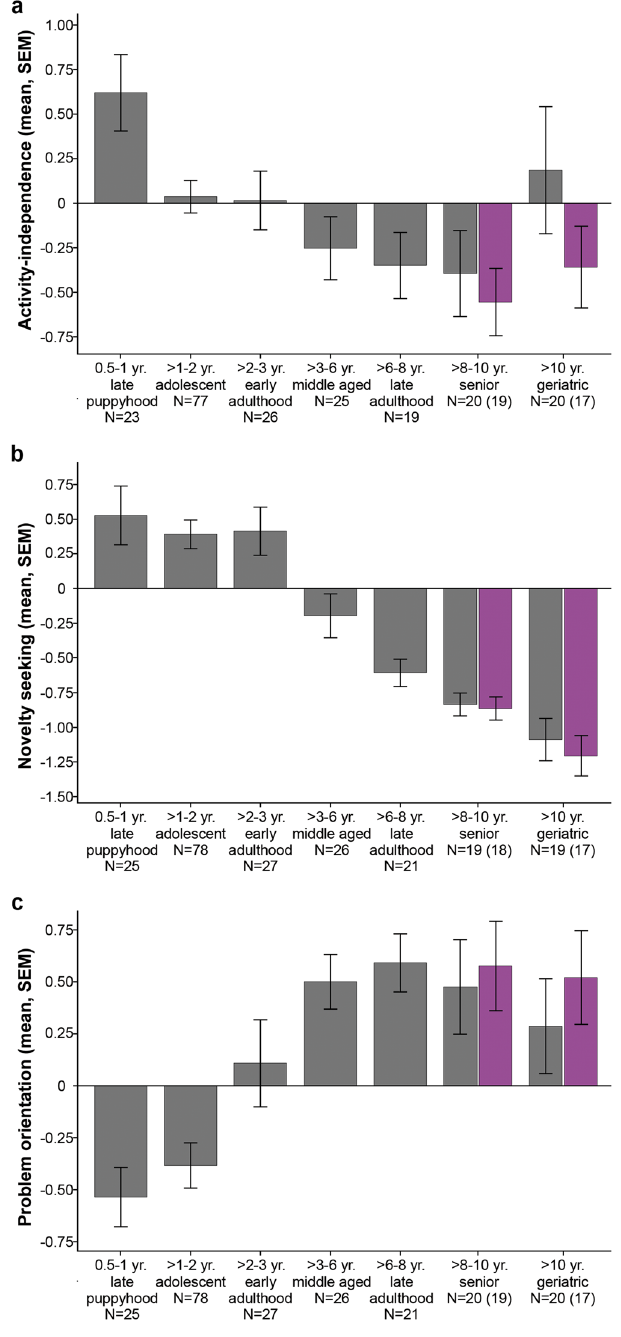
Figure 2. Differences between seven age groups in ( a ) Activity-independence, ( b ) Novelty seeking, and ( c ) Problem orientation traits. The grey bars in the senior and geriatric groups represent the full sample, the lilac bars the sample after excluding the four outlier